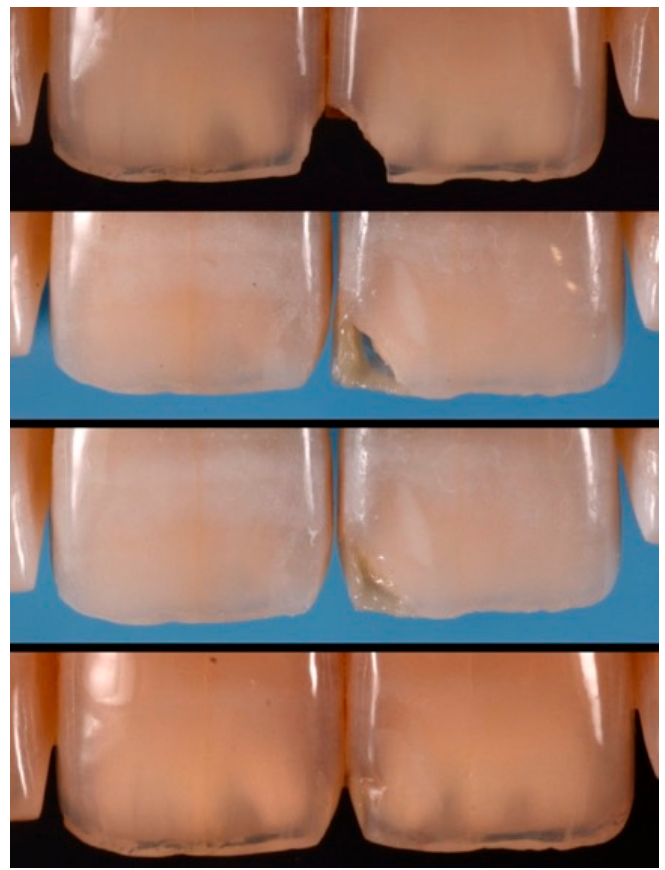
Figure 40. Pre-operative, restorative procedures and post-operative of #1.1 and #2.1. Reprinted from Restauri diretti nei settori anteriori, G. Paolone, S. Scolavino, © 2021, with permission from Quintessence Publishing Italy.